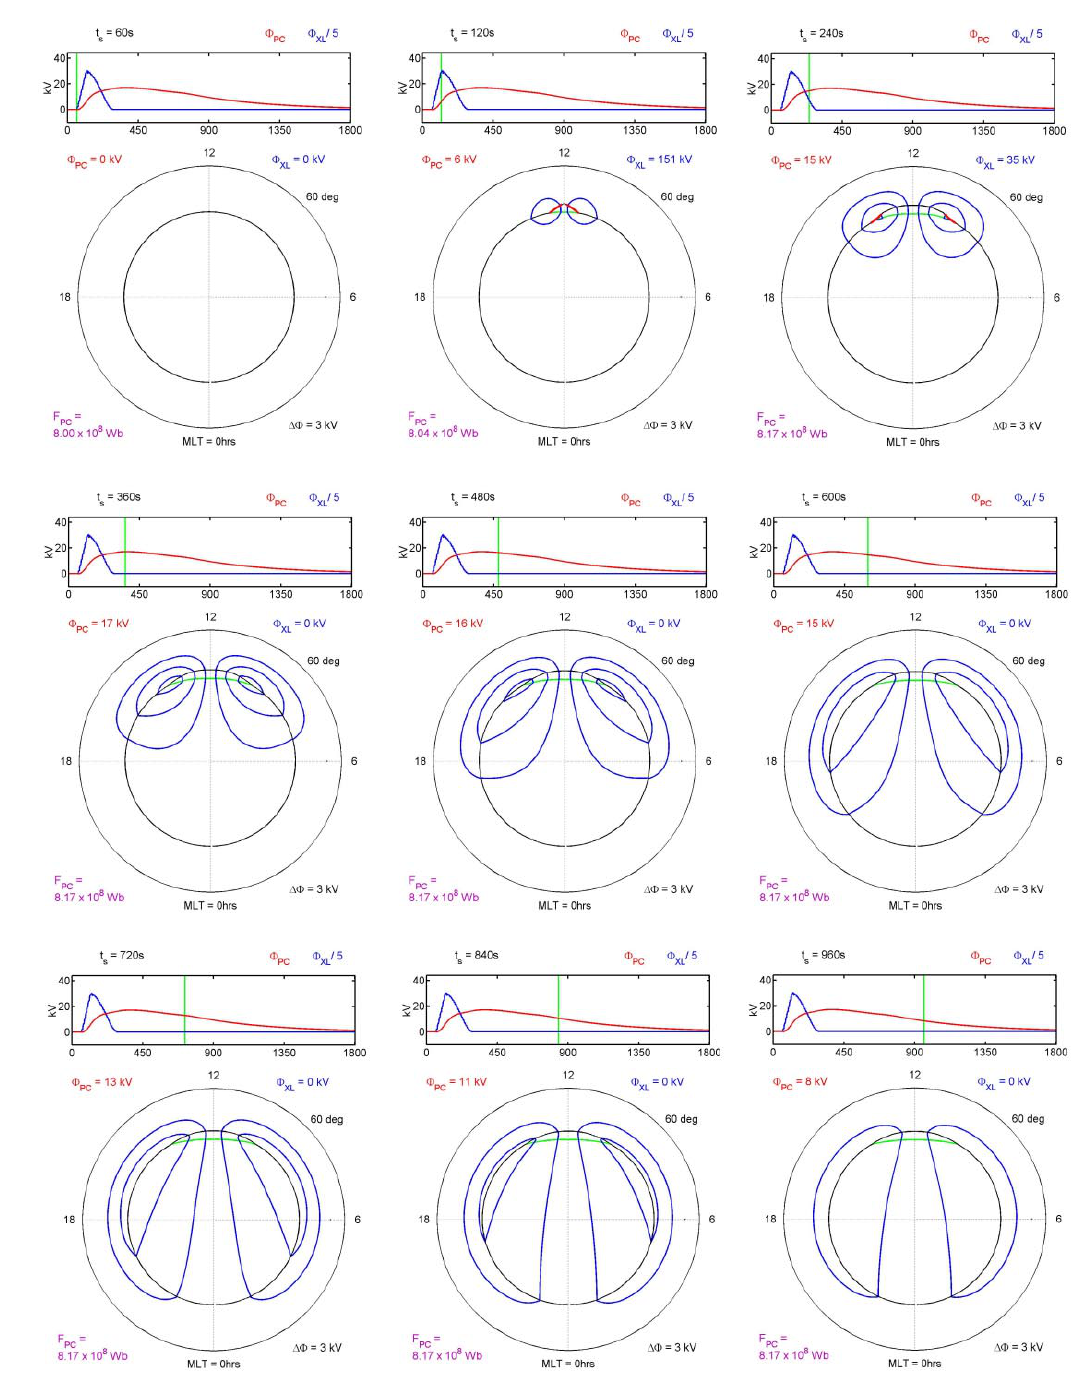
Fig. 2. Multiple output convection patterns from the model. Each frame has two panels. The top panel shows the variation with simulation time, t s , of the input reconnection voltage (in blue), 8 XL divided by five to fit the same scale as the resulting transpolar voltage (in red), 8 PC . The simulation time of the output frame is marked by the vertical green line. The lower panel shows the convection pattern (using 3kV equipotentials) plotted in an MLT-invariant latitude coordinate system. The outer circle represents the equatorward boundary of the modelled region and the inner circle represents the OCB. Non-reconnecting segments of the OCB are shown in black, while active x-line footpoints are marked in red. The green line delineates the region of newly-opened flux. The convection plots are shown with a two minute spacing, except for frame (a) (top row, left column) which is for t s =